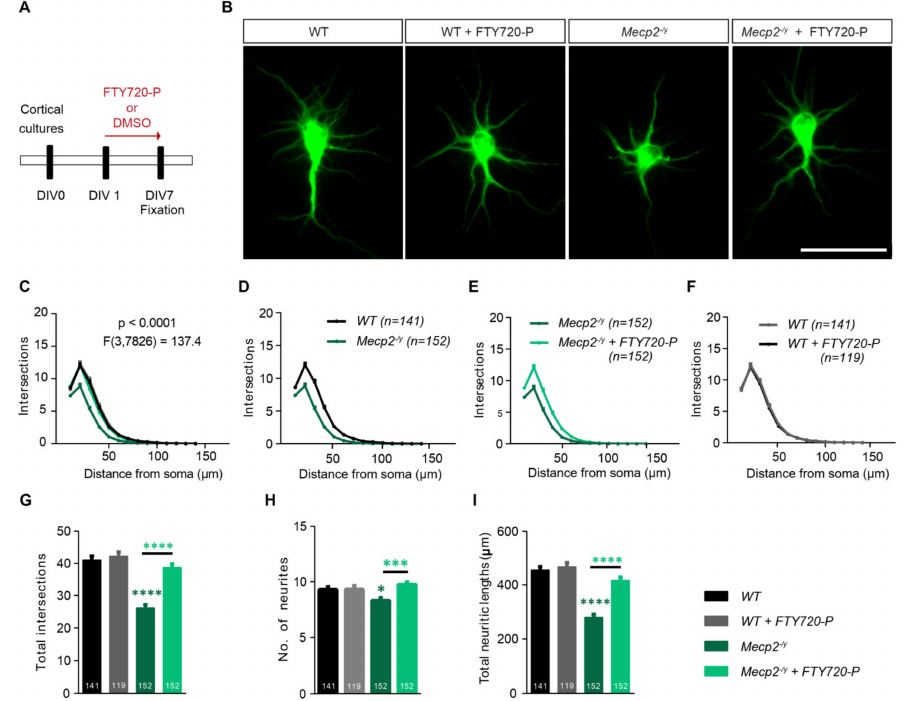
Figure 4. Fingolimod-phosphate (FTY720-P) completely rescues the neuronal architecture in developing Mecp - / y cortical neurons. Young DIV7 cortical cultures from Mecp2 - / y mice or littermate wild type (WT) controls were allowed to develop for one week with either DMSO alone or with 10nM FTY720-P in the growth medium. ( A ) The diagram shows the scheme of treatment from culture preparation on DIV0, treatment from DIV1 to fixation on DIV7. ( B ) Micrographs showing representative fluorescent images of DIV7 WT and Mecp2 - / y cortical neurons stained for MAP2 and treated with either DMSO or FTY720-P. Scale bar: 50 µ m. Neurite complexity plotted as number of neurite intersections against the distance from the soma for: ( C ) all four test groups- WT (black), WT neurons treated with 10nM FTY720-P (gray), Mecp2 - / y (dark green) and Mecp2 - / y neurons treated with 10nM FTY720-P (light green). F value for comparison between all sets is described with the graph. For better visualization of di ff erences between di ff erent pairs, Sholl curves are also plotted separately: ( D ) WT (black) and Mecp2 - / y (dark green) neurons ( E ) Mecp2 - / y neurons treated with 10nM FTY720-P (light green) v / s DMSO controls (dark green) and ( F ) WT neurons treated with 10nM FTY720-P (gray) v / s DMSO controls (black). ( G ) Total intersections, ( H ) number of neurites and ( I ) total length of neurites as computed for WT neurons treated with DMSO (black) or FTY720-P (gray) and Mecp2 - / y treated with DMSO (dark green) or FTY720-P (light green). Data in graphs is plotted as mean + SEM. Numbers in the bars show total number of neurons analyzed for each genotype and treatment, obtained from ≥ 3 sets of independent experiments. Two-way ANOVA followed by Bonferroni post-hoc test was used in A. For G,H and I one-way ANOVA with Bonferroni post-hoc was used. Denotations for significance are *** p < 0.001, **** p <